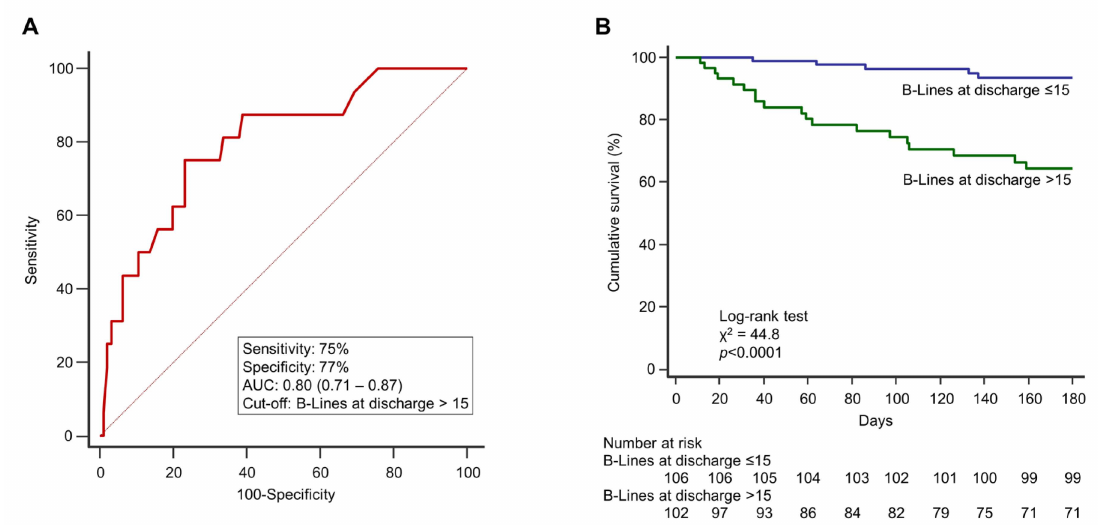
Figure 2. ( A ) ROC curve analysis describing the performance of B-lines at discharge to identify the primary endpoint (rehospitalization for heart failure and cardiovascular death at 6 months). The AUC and 95% confidence interval are shown, as well as the sensitivity, and the specificity at the cut-off identified based on the highest Youden index. ( B ) Kaplan-Meier survival curves stratified according to the ROC-derived cut-off. The curves illustrate a significant difference in cumulative survival, with patients discharged with >15 B-lines experiencing a worse outcome than those having B-lines ≤ 15. Numbers of patients at risk are shown below the survival curves. AUC: area under the curve; ROC: receiver operating